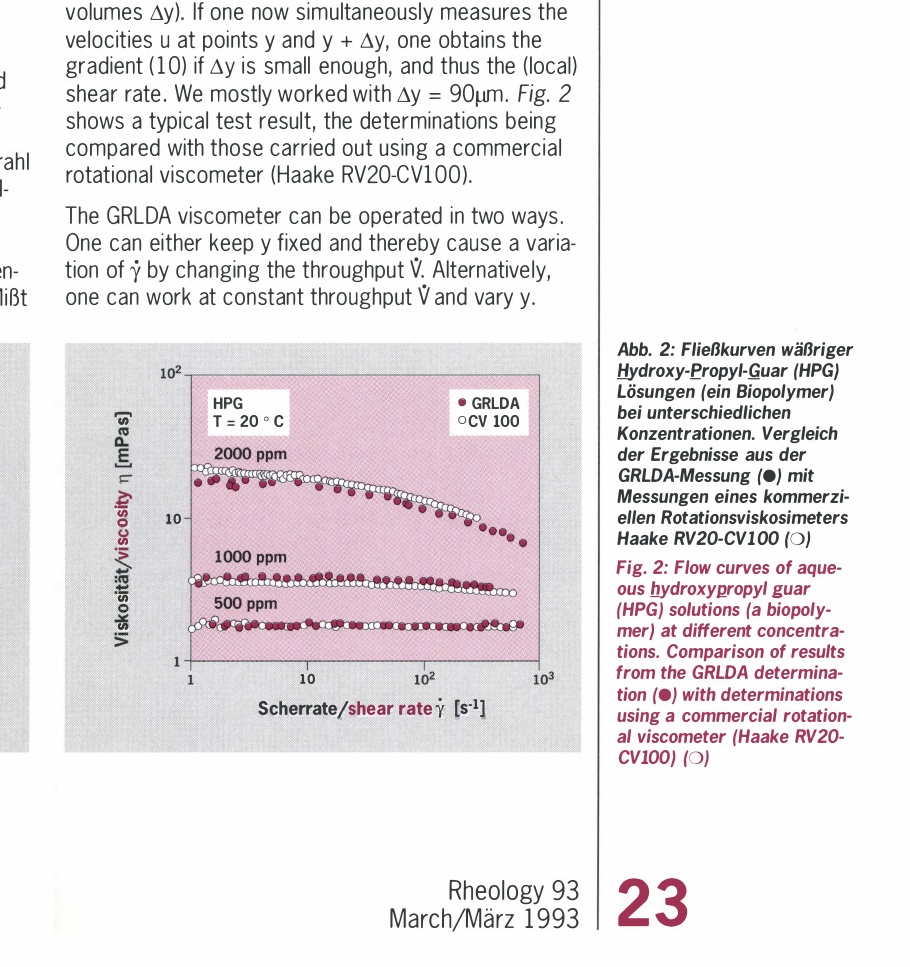
Fig. 2: Flow curves of aque­ ous l!ydroxygropyl guar (HPG} solutions (a biopoly­ mer] at different concentra­ tions. Comparison of results from the GRLDA determina­ tion (e) with determinations using a commercial